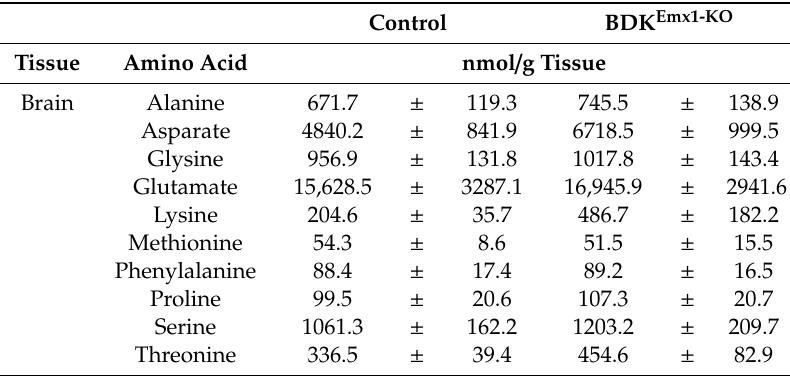
Table 2. Brain amino acids in the control and BDK Emx1-KO mice.